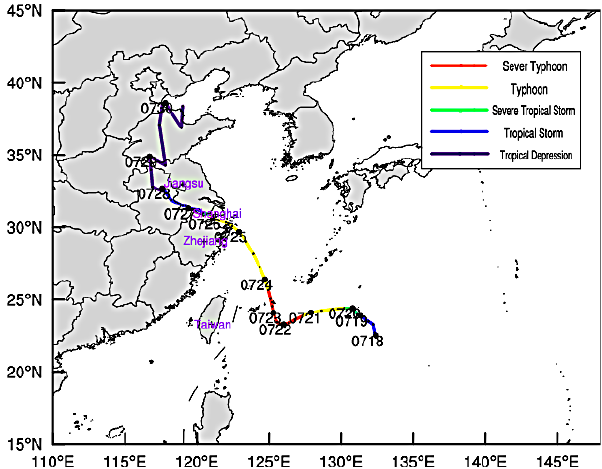
Figure 2. The best-track and intensity evolution for Super Typhoon In-Fa every 24 h from 18 July 2021 to 30 July 2021.